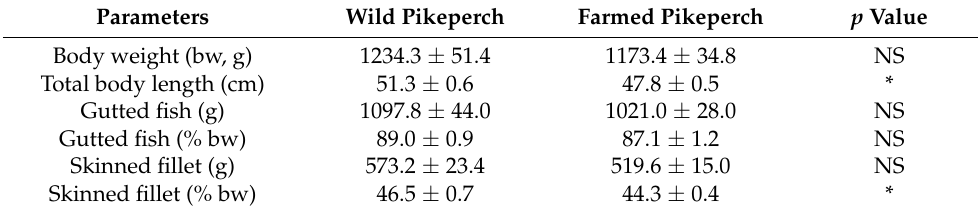
Table 1. Characteristics of fish (mean values ± standard error; n = 12).